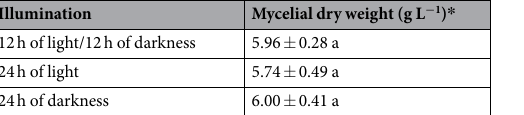
Table 4. Effect of illumination on the mycelial growth of Isaria farinosa . * Mean ± SE. Values followed by the same letters within a column do not differ significantly (ANOVA, P = 0.05).